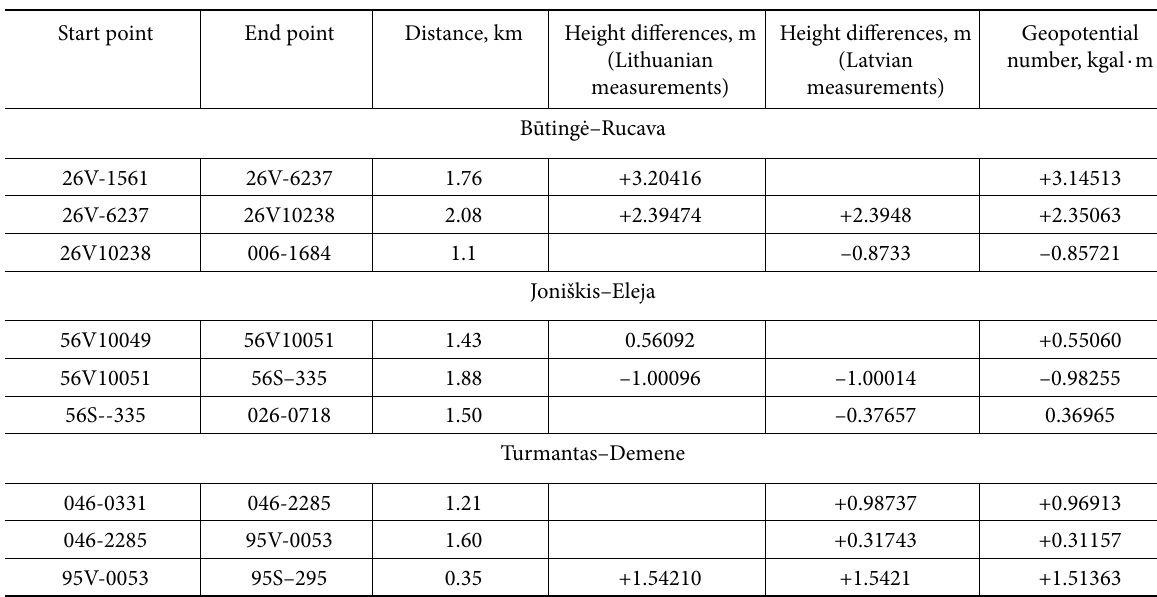
Table 6. Data on height differences of the connecting lines Start